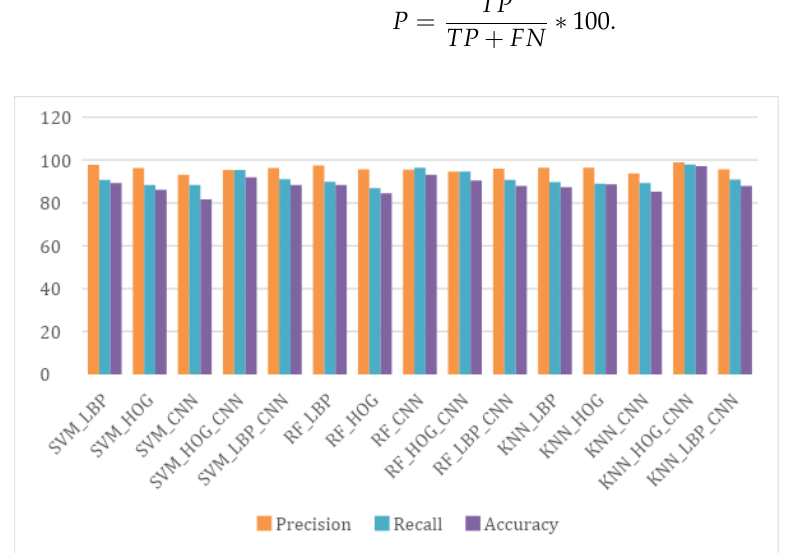
Figure 9. Comparison among the Proposed Algorithms to Select the